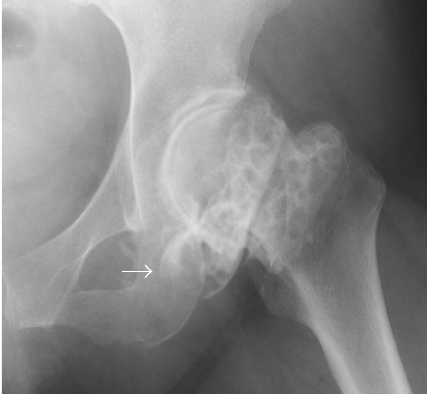
Figure 7: Arthrography of the hip. There are many loose bodies in the left hip joint (honeycomb appearance: arrow).